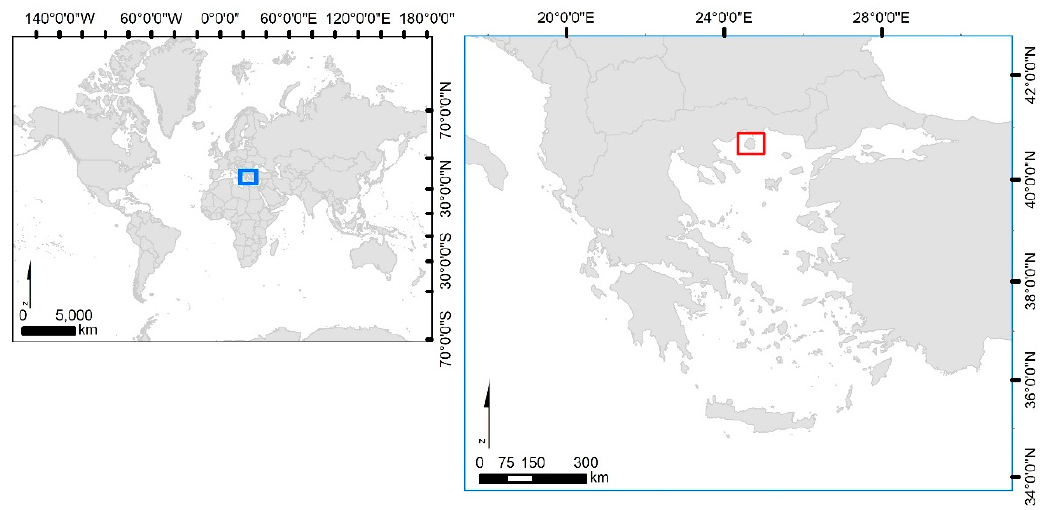
Figure 1. Location of the study area.